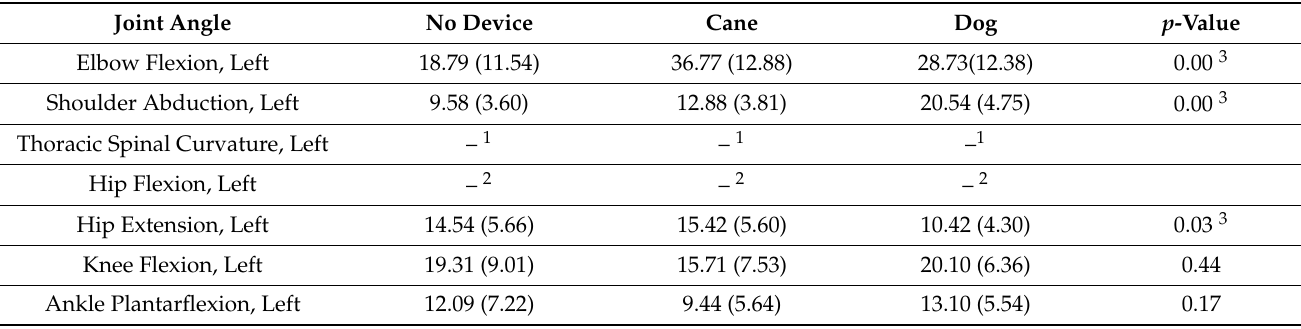
Table 2. Mean and standard deviation of specified joint angles for all participants under each condition, measured in degrees, and calculated p -values obtained from Friedman’s test, for left